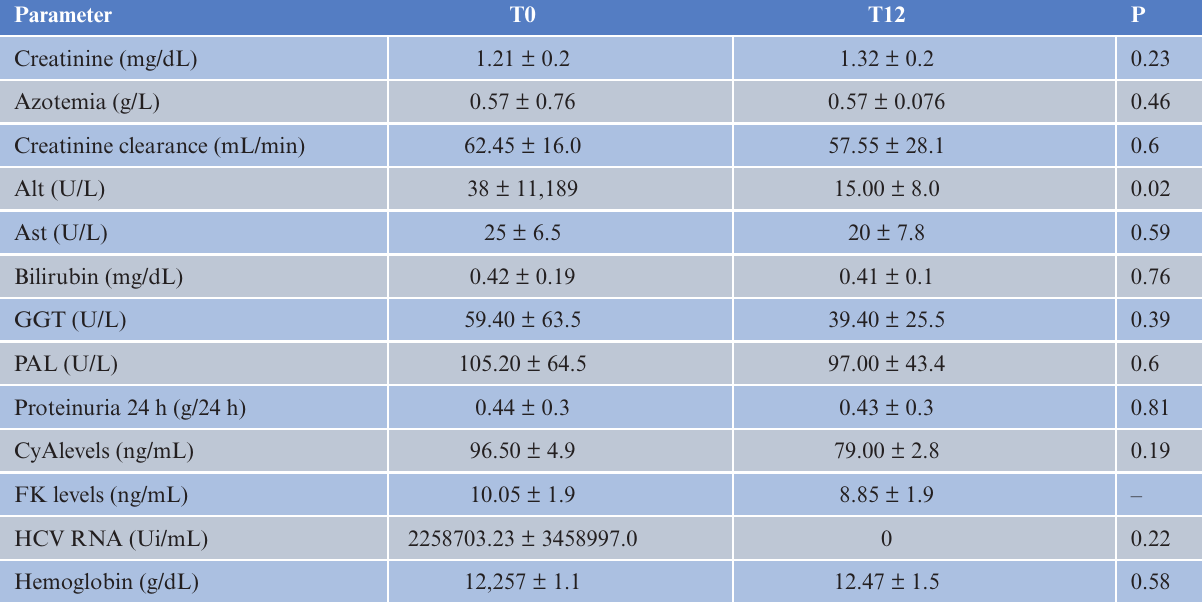
Table 2. Variation of the parameters at the beginning and after 12 weeks of therapy with Direct Acting Antivirals (DAA). Parameters are expressed as means and standard